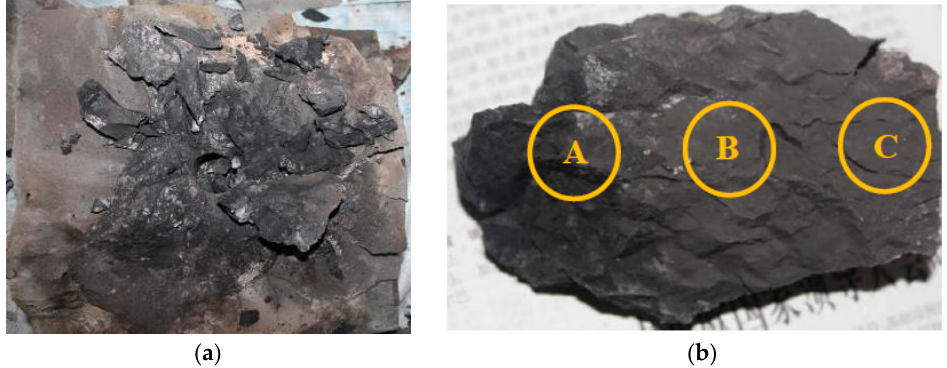
Figure 9. Pyrolized sample: ( a ) Morphology of the oil shale after pyrolysis; ( b ) Sampling locations. The TG curves of oil shale at different locations after pyrolysis are shown in Figure 10. At the temperature of 510 °C, the rates of weight loss of oil shale at Locations A, B and C are 0.17%, 0.72% and 2.31%, respectively, while that of the original oil shale is 10.8%, indicating that the oil shale at each location has been fully pyrolyzed. At the same time, the pyrolysis effect decreases with the increase in distance from the outlet of the heat injection tube. This is because the process of oil shale pyrolysis using superheated steam is an energy consuming process. Farther from the outlet of the heat injection tube, lower is the temperature and worse is the pyrolysis effect.